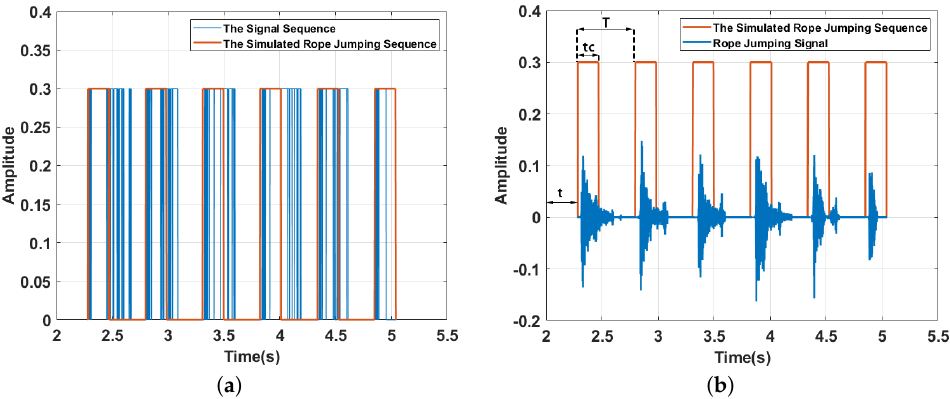
Figure 5. An example of generating the simulated rope jumping sequence. ( a ) Comparison of two generated sequences. ( b ) rope − jumping sound